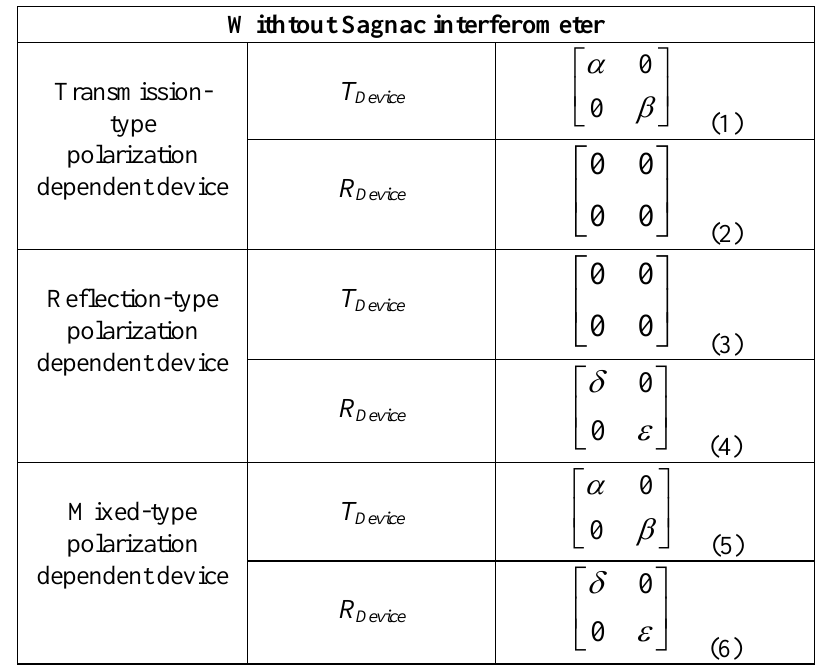
Table 1. Transmission and Reflection of each type of PDL device are presented in Jones matrix